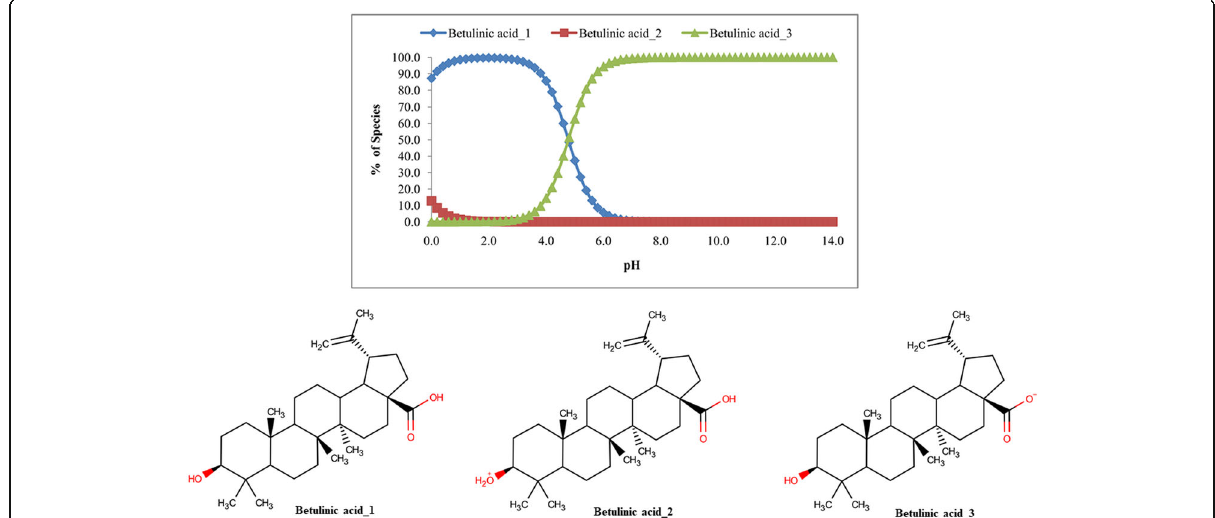
Fig. 5 Microspecies distribution (%) of betulinic